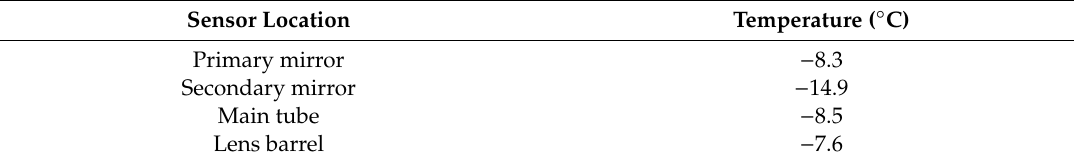
Figure 2. Schematic of the ground resolution test. Table 1. Temperature under the thermal control.